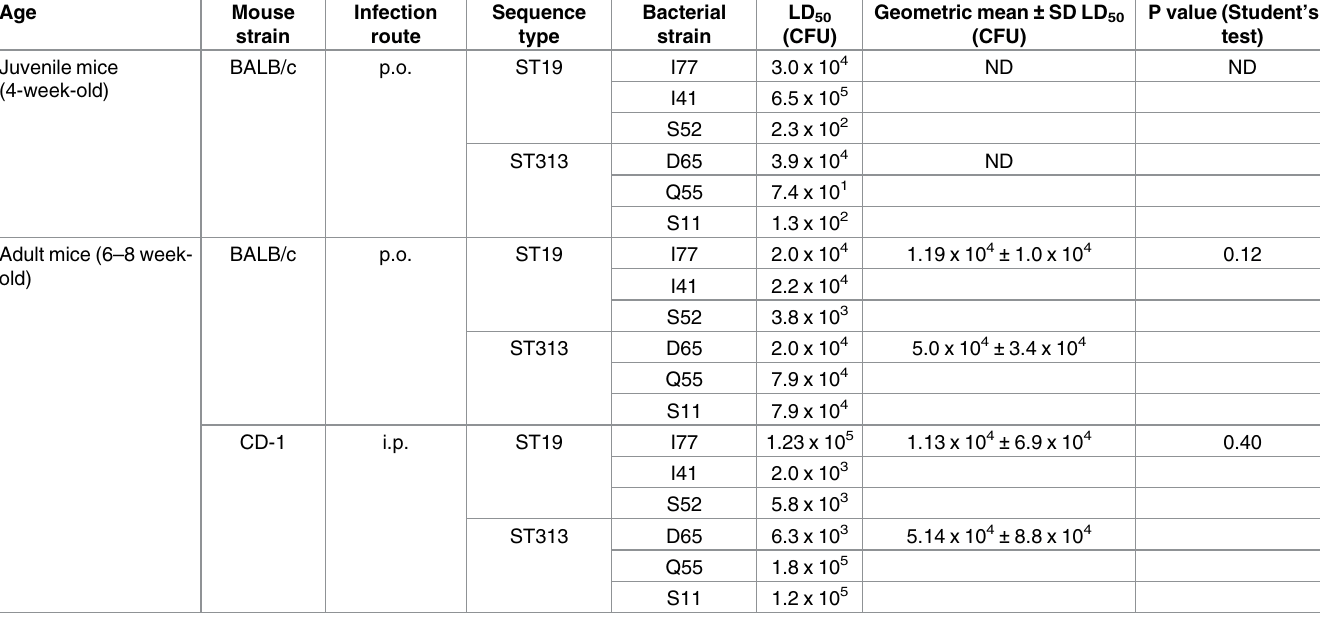
Table 1. 50% lethal dose of ST19 and ST313 strains in juvenile BALB/c and adult BALB/c and CD-1